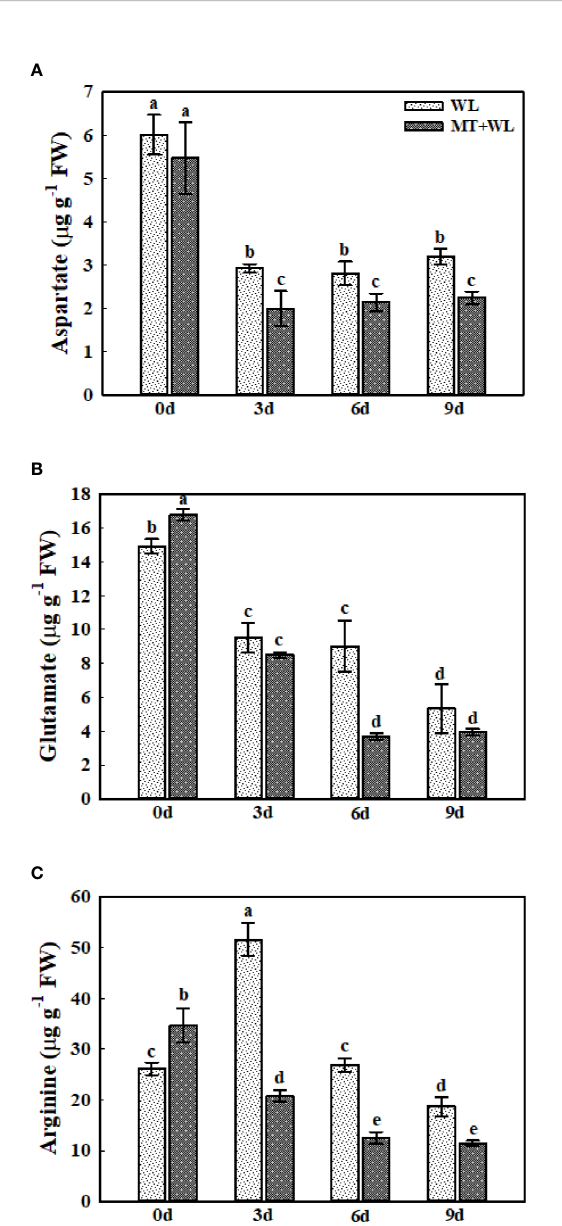
FIGURE 6 The concentrations of Asp, Glu, and Arg in the roots of kiwifruit plants under waterlogging stress, as measured by LC-MS. (A) Asp. (B) Glu. (C) Arg. Data are shown as the means of three replicates with SEs. Different letters indicate signi fi cant differences between treatments, according to one-way ANOVA and Tukey ’ s multiple range test (P <